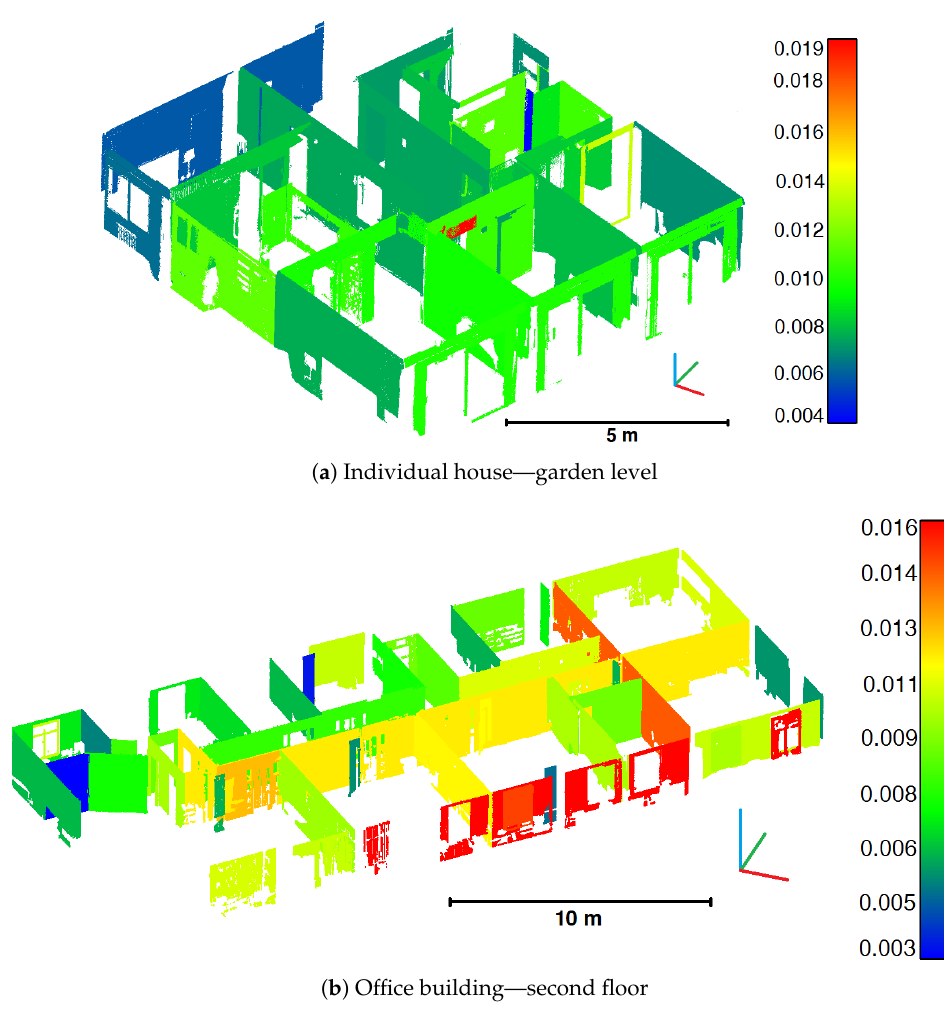
Figure 16. Visualisation of standard deviations associated to walls (colour-bar unit in